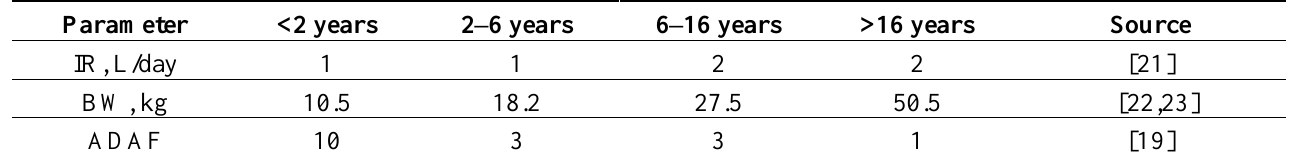
Table 1. Age-specific model